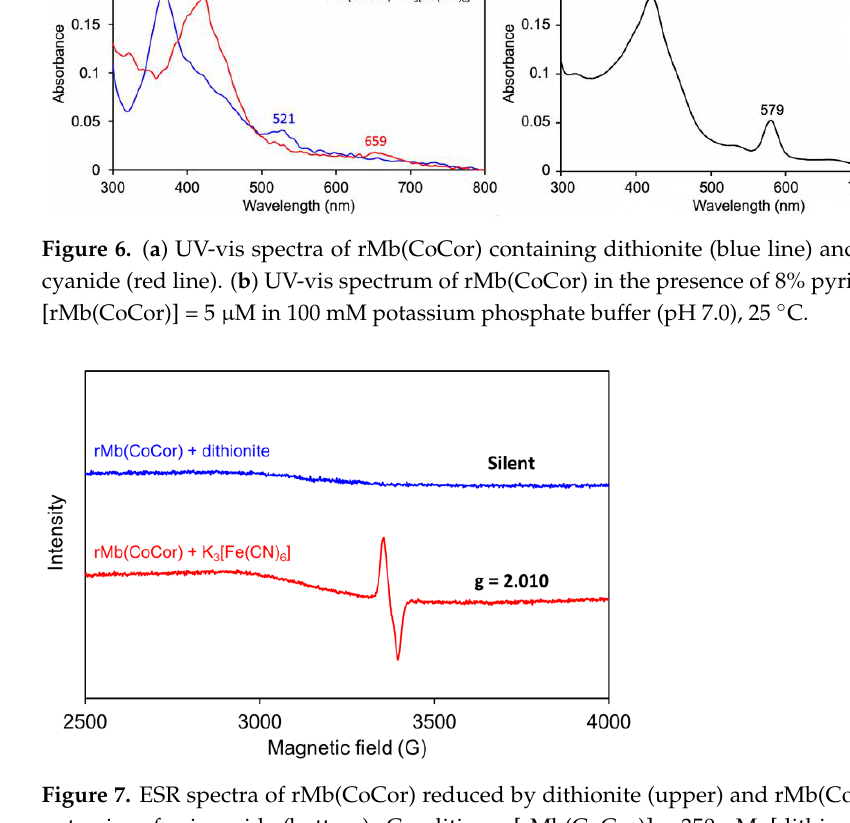
Figure 8. ( a ) UV-vis spectral changes of rMb(CoCor) during applied voltage changing from −50 mV to 300 mV (vs. Ag|AgCl). ( b ) Differential spectra of ( a ). ( c ) Absorption changes at 425 nm in ( a ) against the potentials. ( d ) Nernst plots obtained by spectroelectrochemical measurement of rMb(CoCor). [rMb(CoCor)] = 150 μM, [hydroquinone] = 1.5 mM in 100 mM potassium phosphate buffer (pH 7.0), 25 °C. 2.3. Reaction of rMb(CoCor) with Hydrogen Peroxide in the Presence of Phenol Derivatives In our previous work, it was determined that myoglobin reconstituted with FeCor has much higher catalytic activity than nMb for oxidation of guaiacol (2-methoxyphenol) using hydrogen peroxide [10]. Thus, oxidation activity of rMb(CoCor) for the one-electron oxidation of guaiacol was evaluated. Although the reaction of rMb(Co III Cor) with 1 mM guaiacol in the presence of 40 mM hydrogen peroxide provided a slight increase in ab- sorption at 470 nm which is a characteristic absorption for oxidized product of guaiacol, the amount is negligible relative to nMb and rMb(FeCor). To check the reactivity of rMb(Co III Cor) with hydrogen peroxide, the transient UV-vis spectral changes of an 8 µM rMb(Co III Cor) solution upon addition of 10 mM hydrogen peroxide in the absence and presence of guaiacol were monitored using a stoppered-flow apparatus (Figure 9). Differ- ent spectral changes were observed: absorption bands at 370 nm and 521 nm decrease and